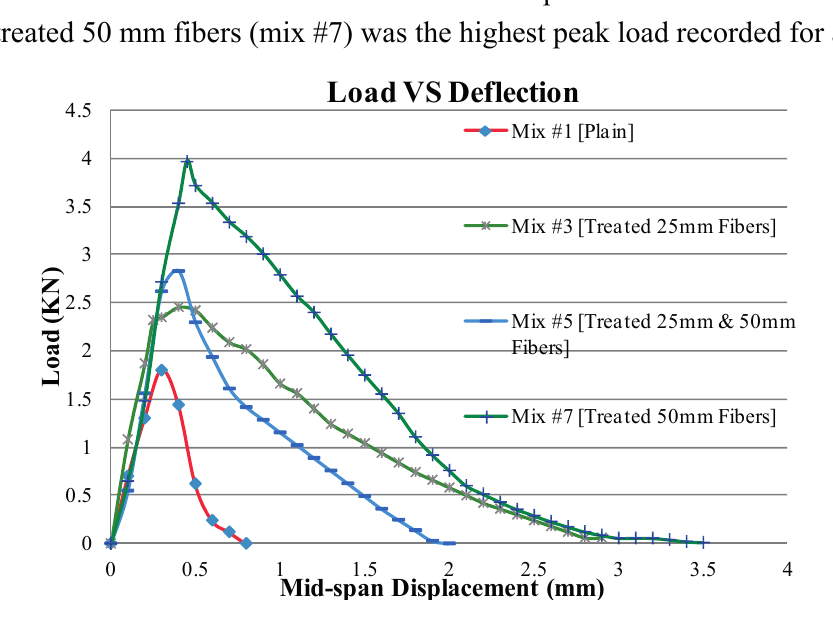
Figure 9. Typical load-deflection curves for GCEBs Mixes.